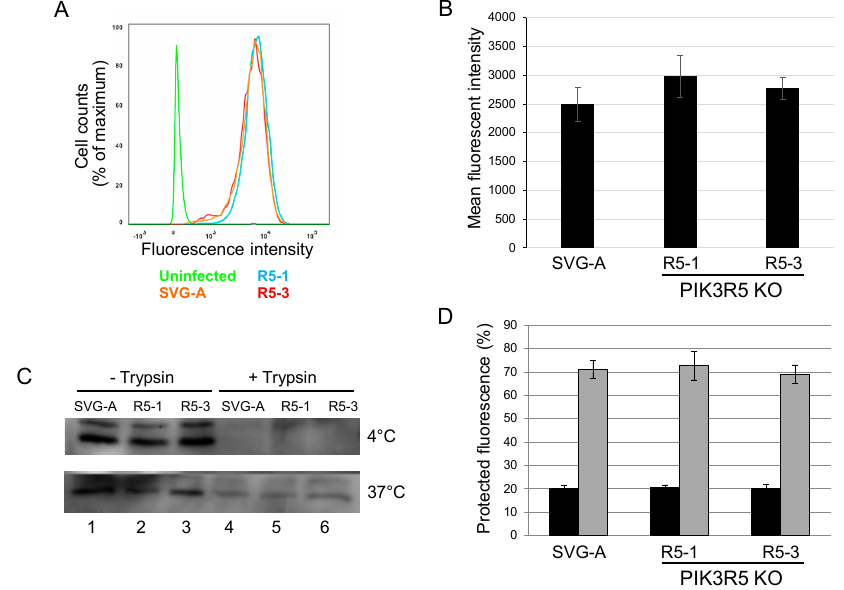
Figure 5. PI3K γ is not required for JC polyomavirus binding or internalization. ( A ). Parental SVG-A cells and PI3K γ knockout cells (clones R5-1 and R5-3) were incubated with Alexafluor633-labeled JCPyV on ice for 2 h and fixed in 1% PFA. Fluorescence intensity was measured by flow cytometry and shown as a histogram. Fluorescence of cells not exposed to virus is shown in green. ( B ). Quantitation of experiments as in panel A. Average and standard error of three independent experiments are shown. ( C ). Western blot analysis of virus binding and internalization. Parental SVG-A cells or PIK3R5 knockout cells (clones R5-1 and R5-3) were incubated with 5000 GE JCPsV for 1 h at 4 ◦ C. One set of cells (top panel) was immediately processed by direct lysis or lysis after incubation in 0.25% trypsin. Another set of cells (bottom panel) was shifted to 37 ◦ C and harvested 6 h.p.i. by direct lysis or trypsin treatment as above. ( D ). Parental SVG-A cells and PIK3R5 knockout SVG-A cells were incubated with Alexafluor633-labeled JCPsV for 1 h on ice and harvested (black bars). After 2 h at 0 ◦ C, cells were shifted to 37 ◦ C and virus was allowed to internalize for 1 h prior to analysis (grey bars). After incubation, cells were fixed and imaged by confocal microscopy before and after trypan blue addition. Graph shows fraction of fluorescence that was protected from trypan blue-induced quenching. Maximum fluorescence intensity was calculated by using Image J software.